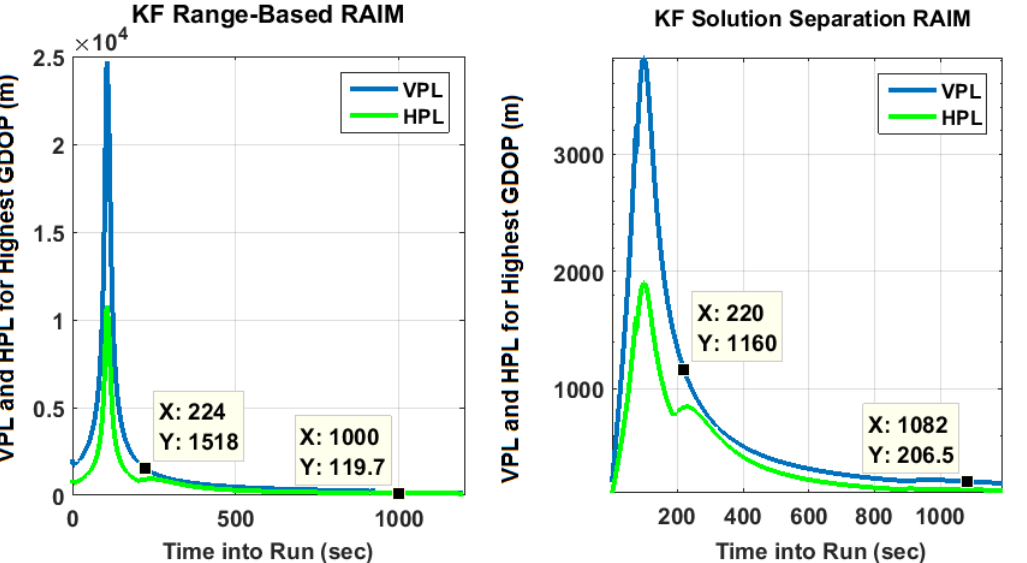
Figure 6. KF PLs with standalone GPS for scenario having the highest GDOP with dual constellations, assuming only single satellite